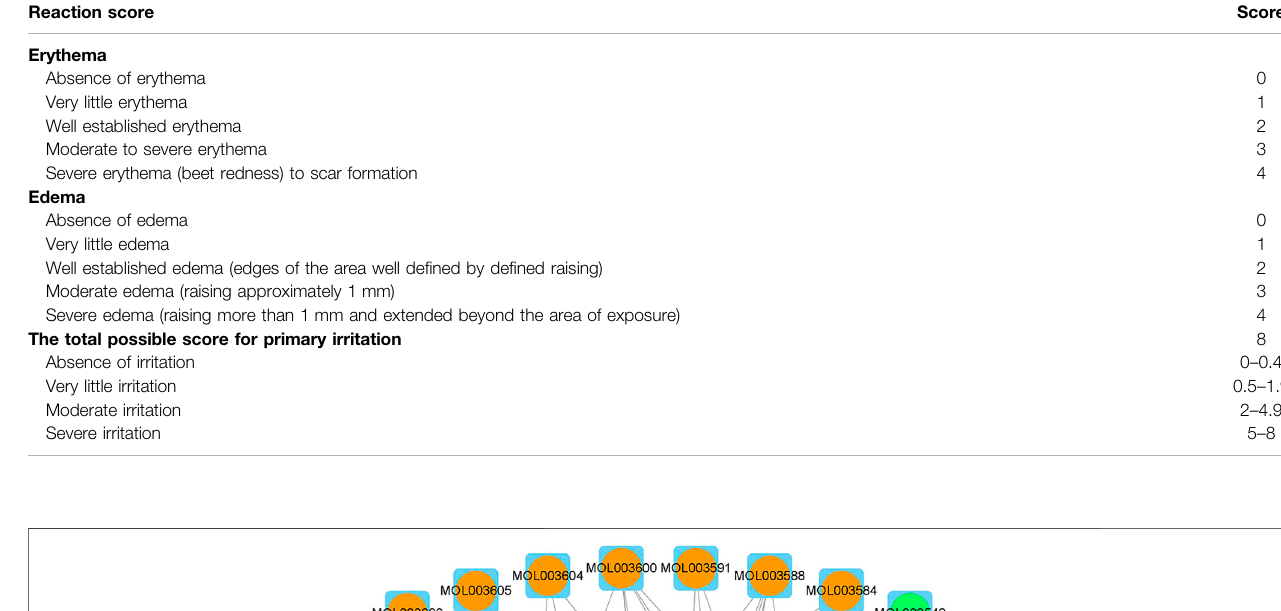
TABLE 1 | Standard scoring system for skin reactions.